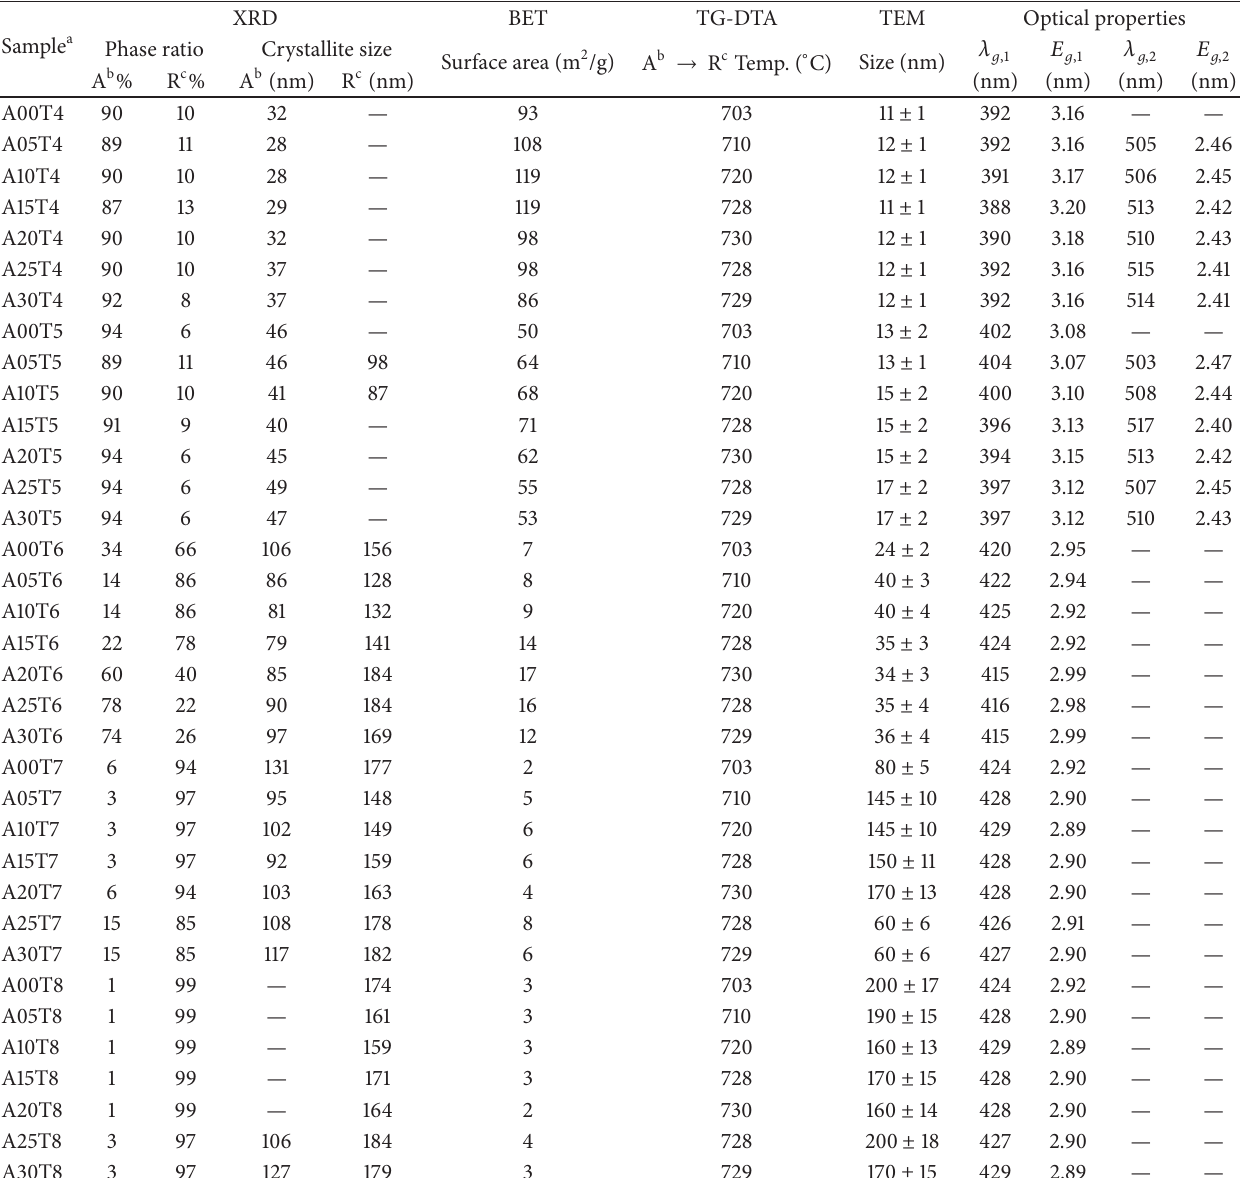
Table 1: Characteristics for N-TiO at various ammonia/TTIP molar ratios under different calcination 2